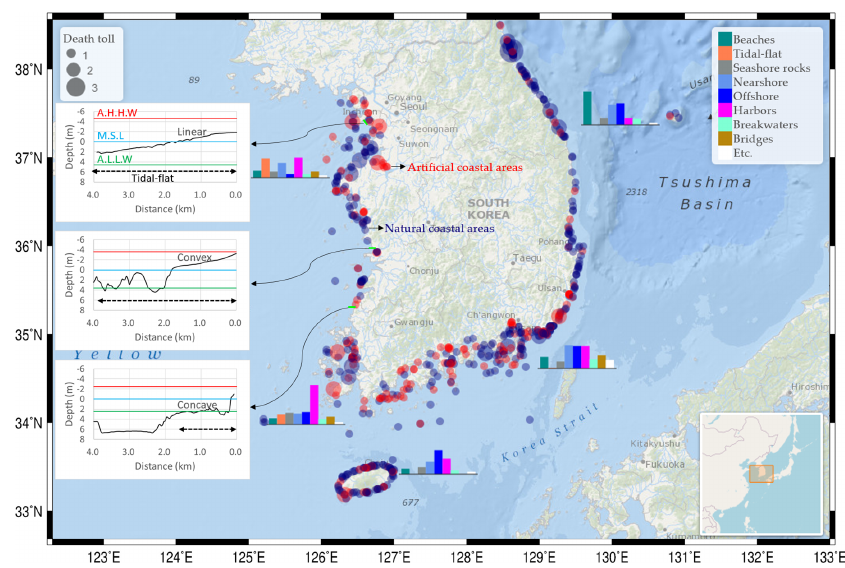
Figure 2. Coastal accidents depending on locations (indicated by different colors) around the